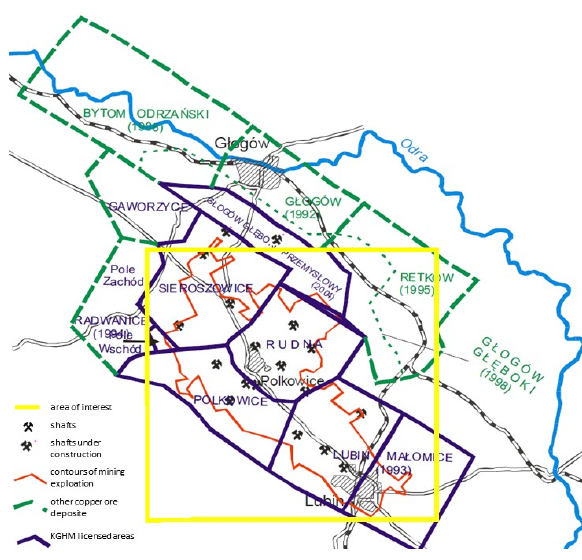
Figure 1. The map of the